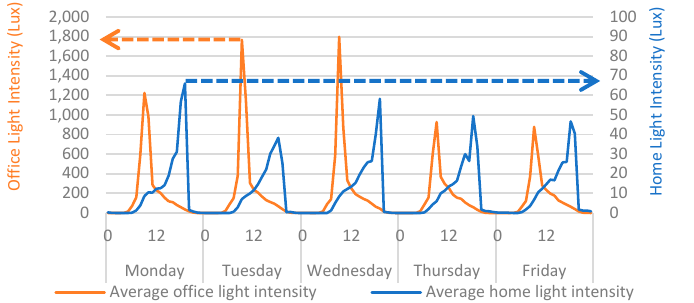
Figure 5. Average home/office light intensity categorised by day > hour. Qualitative findings are displayed alongside the quantitative data for context. Two vertical axes are used here due to scale differences; therefore, colour-coded arrows are used to highlight the scale used by each